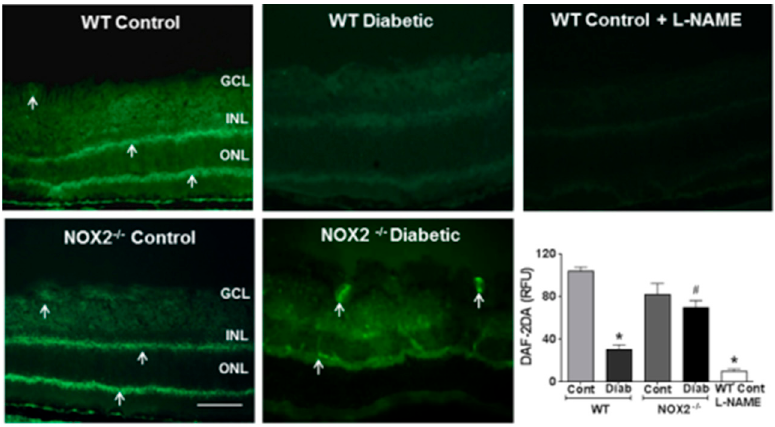
Figure 2. NOX2 deletion prevents diabetes-induced decreases in retinal nitric oxide (NO). Representative images and quantitation showing effects of NOX2 deletion on fluorescence for the NO indicator DAF-2DA (arrows) in diabetic and control retinas. Quantitative analysis showed significant reduction of NO levels in samples from WT diabetic retinas as compared to control retinas. NO was restored by deletion of NOX2. Pretreatment with the NOS inhibitor L-NAME significantly decreased NO in WT retinas. * p < 0.05 vs. WT control, # p < 0.05 vs. WT diabetic. Values are mean ± SEM, n = 4–5. Scale bar = 50 µm.